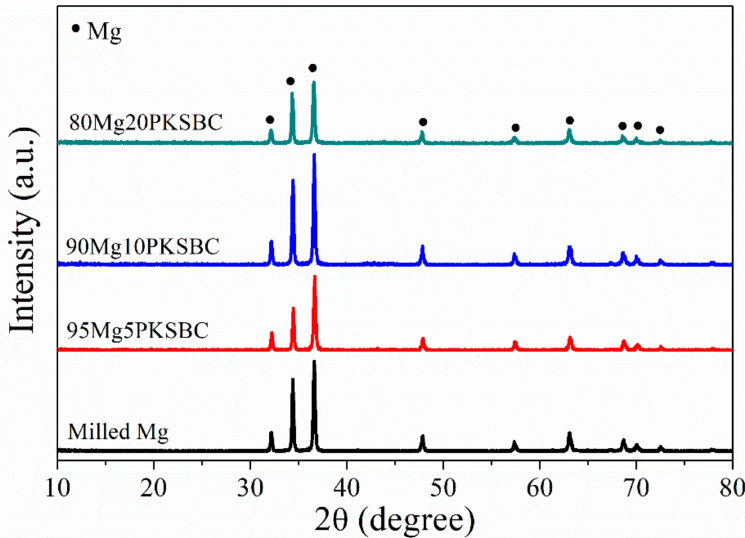
Figure 6. XRD patterns of ball milled Mg / PKSBC composite for 1h at a milling frequency of 30